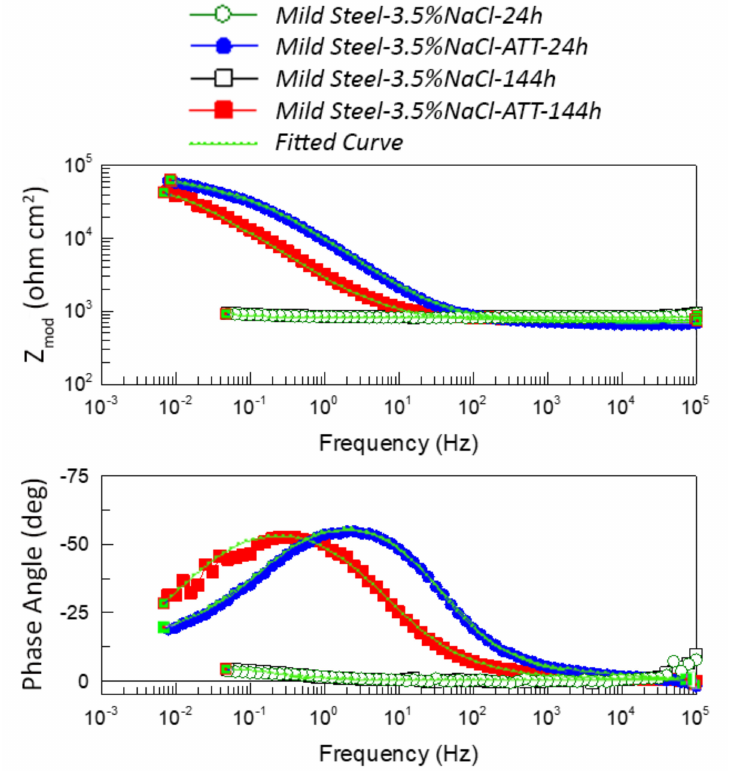
Figure 9. EIS plots recorded after exposure to 3.5 wt.% NaCl for: 24 h Mild Steel-3.5NaCl, (open circle); 24 h Mild Steel-3.5NaCl-ATT, (filled circle); 144 h Mild Steel-3.5NaCl, (open square); 144 h Mild Steel-3.5NaCl-ATT, (filled